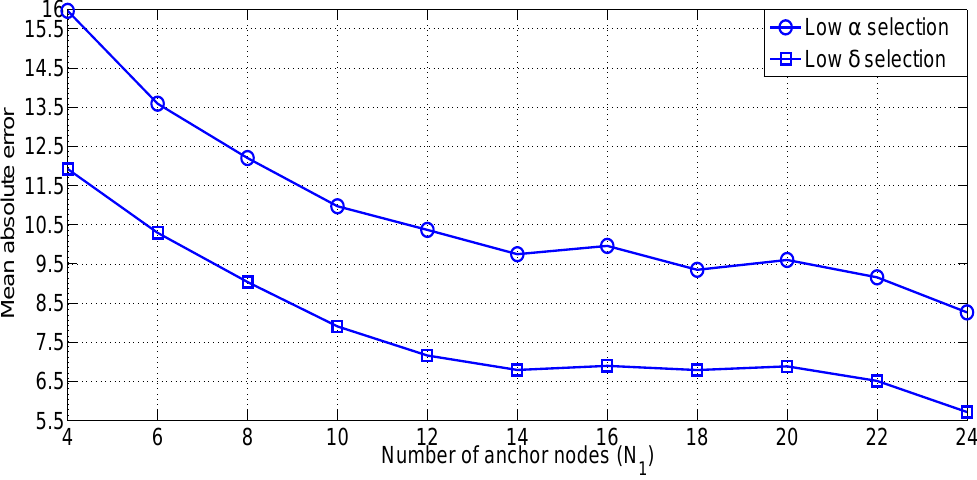
Figure 7. Outage probability ( N